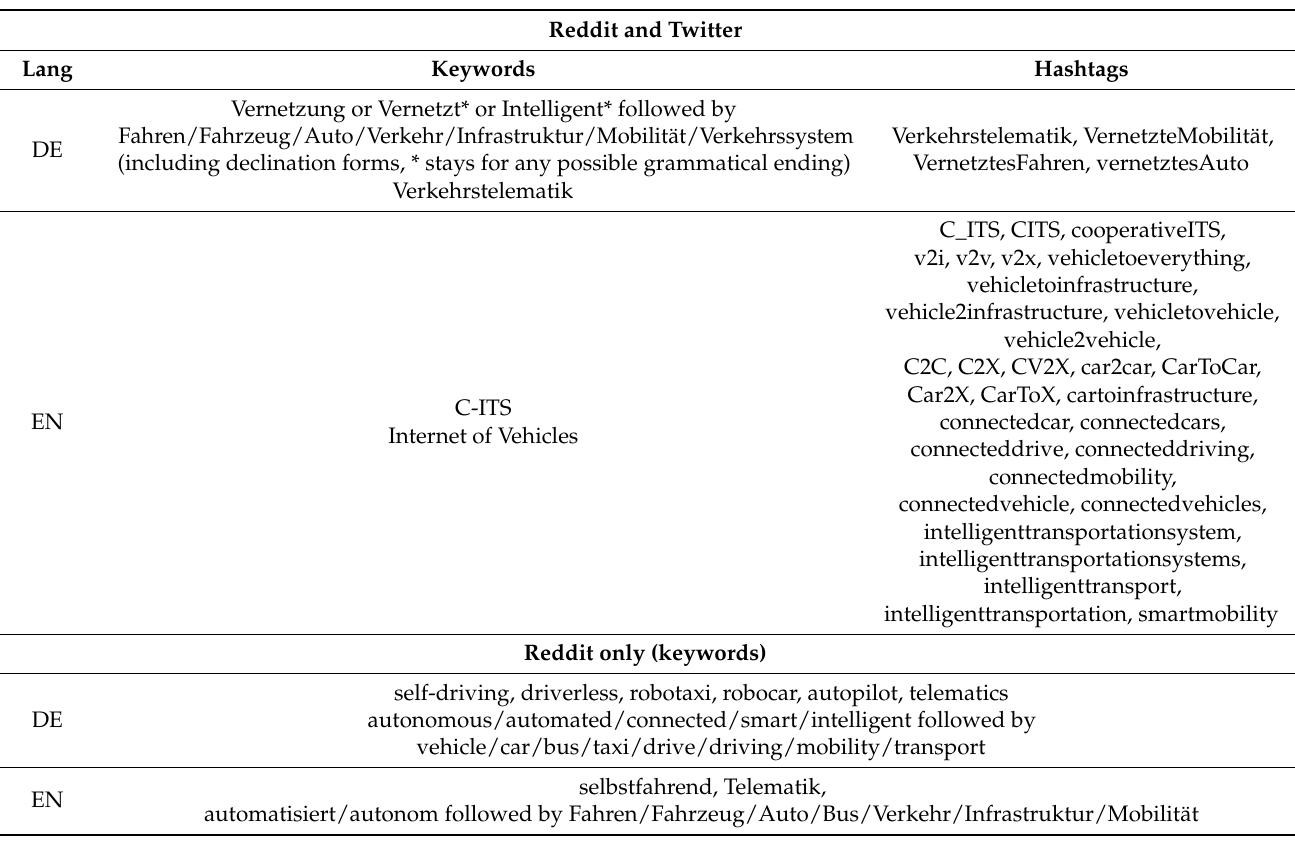
Table 1. Keywords and/or hashtags related to ITS